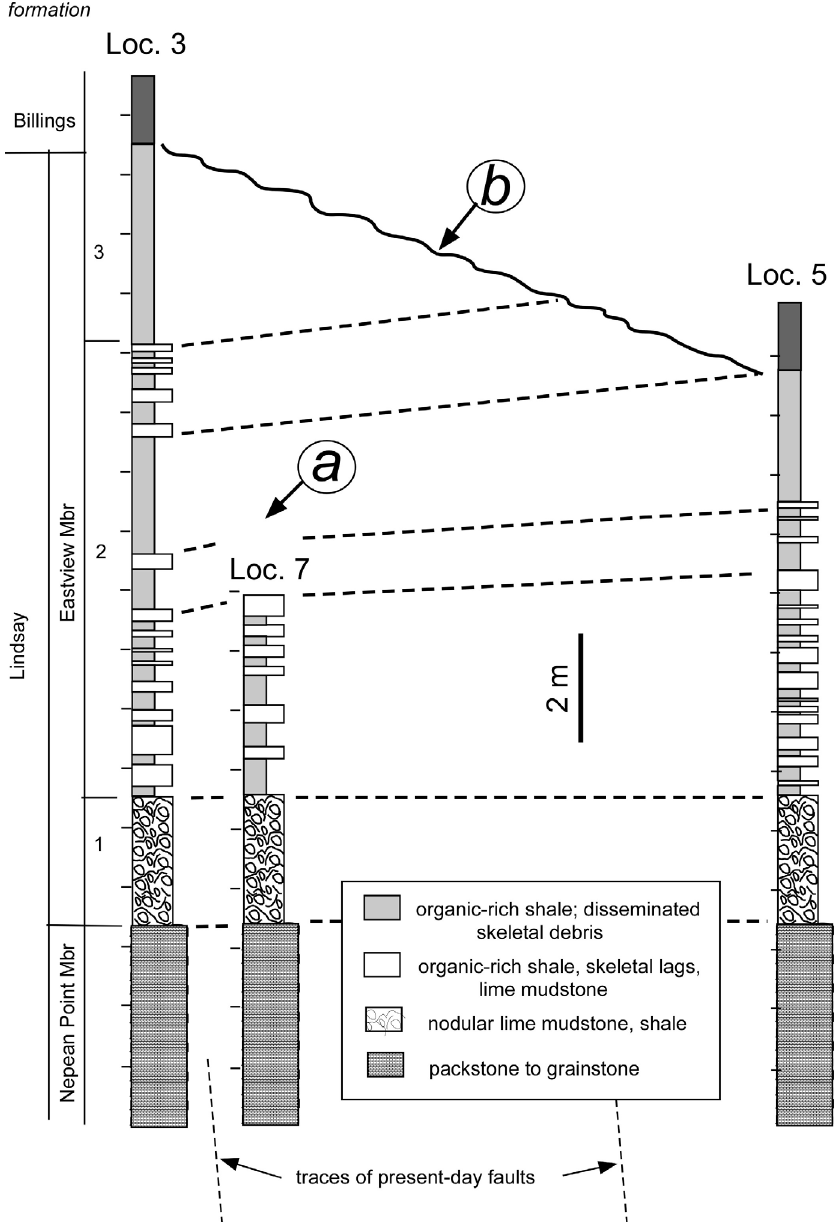
Figure 7. Detailed stratigraphy of the Eastview Member showing vertical succession of a changing carbonate-shale partitioning; a possible thickening between Localities 3 and 7 ( a ); and a disconformity ( b ) with an east-directed increase (~6 m) in stratigraphic